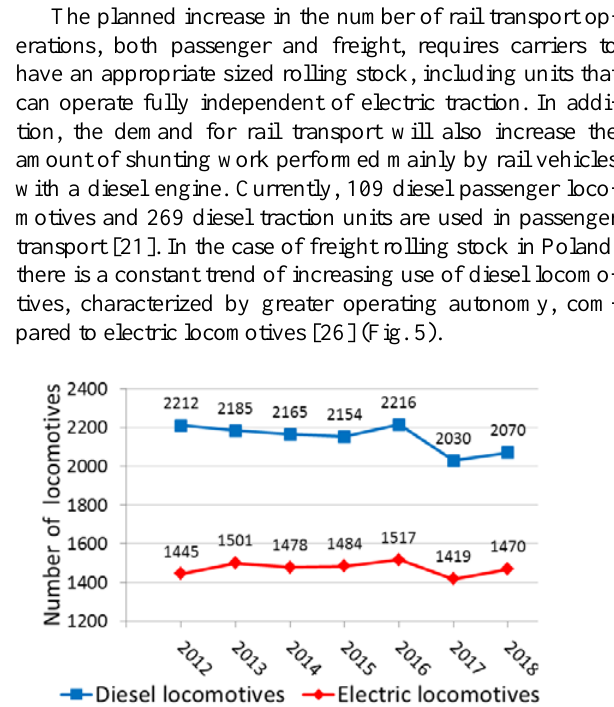
Fig. 4. Share of electrified railway lines in individual voivodships in Poland